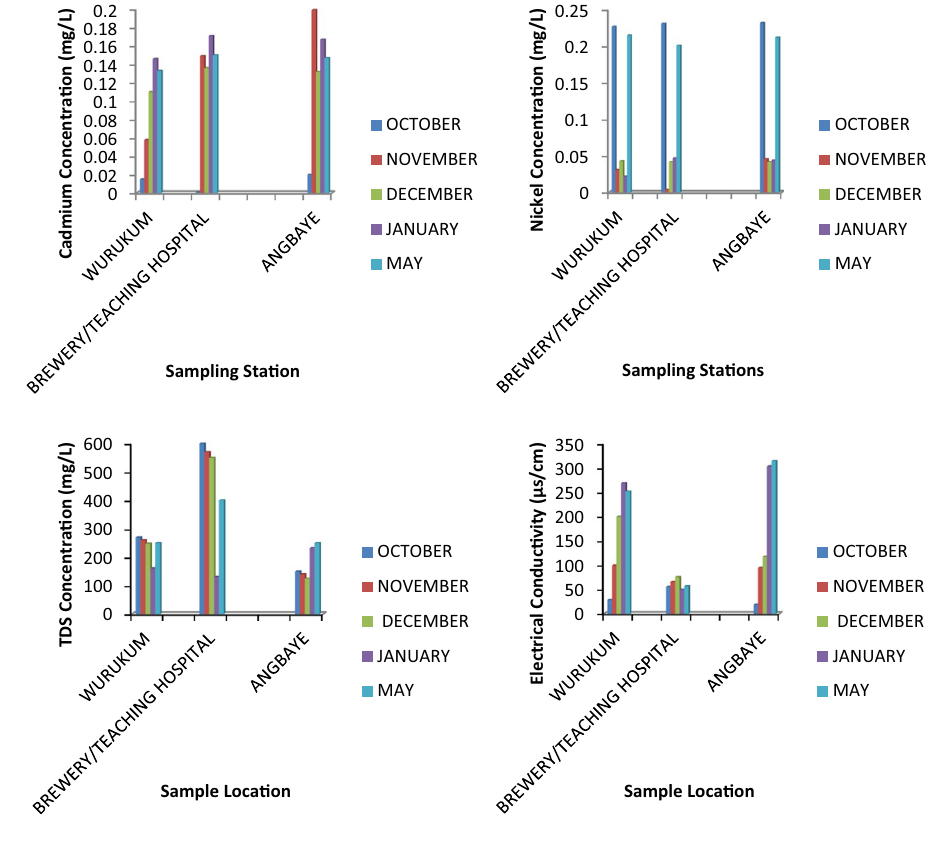
Fig. 4 Spatio-temporal variation in cadmium, nickel, TDS and electrical